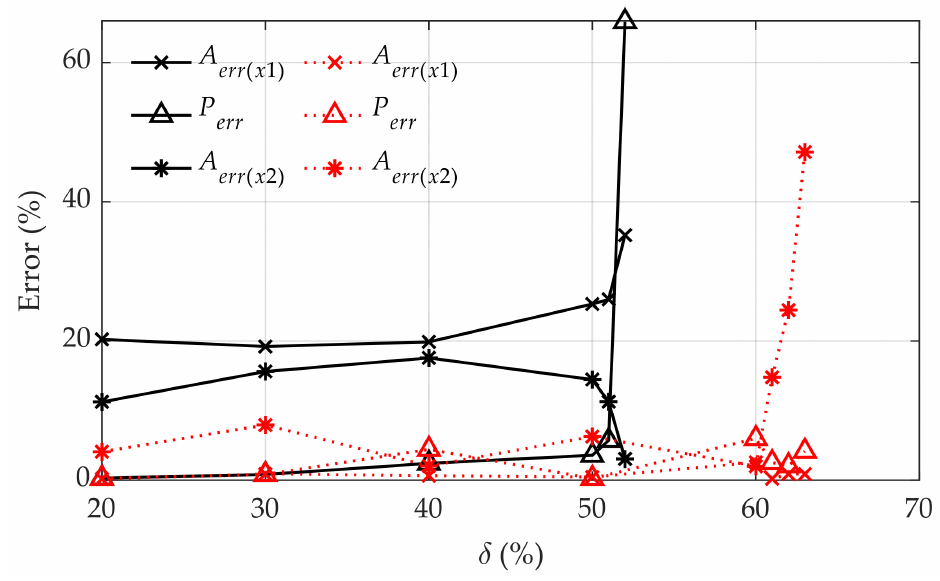
Figure 6. Comparison of errors (Red: constraint dictionary-based sparse representation (CD-SR), Black: sparse representation